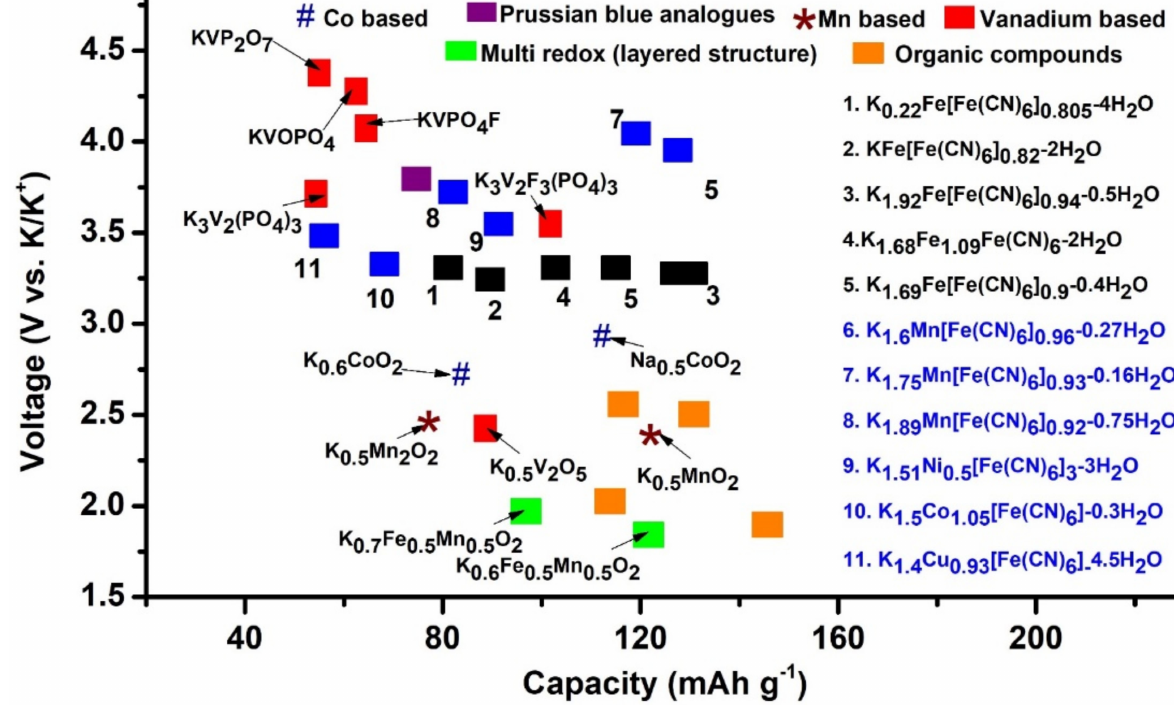
Figure 13. Specific capacities of electrode materials used in potassium-based